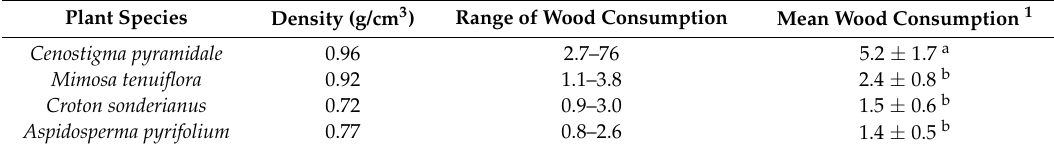
Figure 1. Relationship between population parameters and volume of 14 nests of Microcerotermes indistinctus , at Fazenda Cauaçu, Jo ã o C â mara, Rio Grande do Norte, Brazil. Table 2. Consumption of wood in mg/g termite fresh weight/day by Microcerotermes indistinctus under laboratory